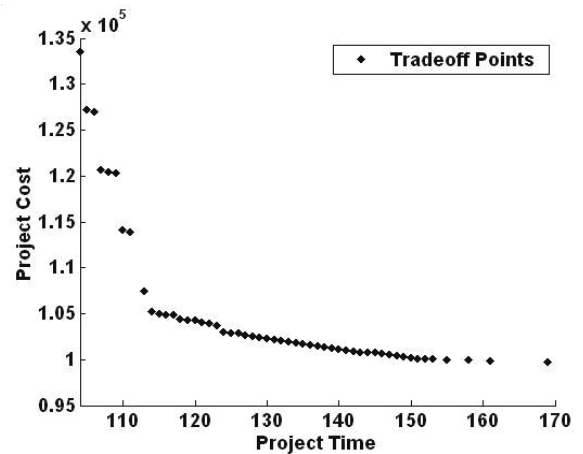
Fig. 11. The Initial generation : First case study